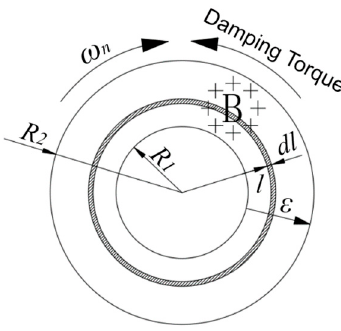
Figure 8. Analysis of the rotor disk potential and damping torque.